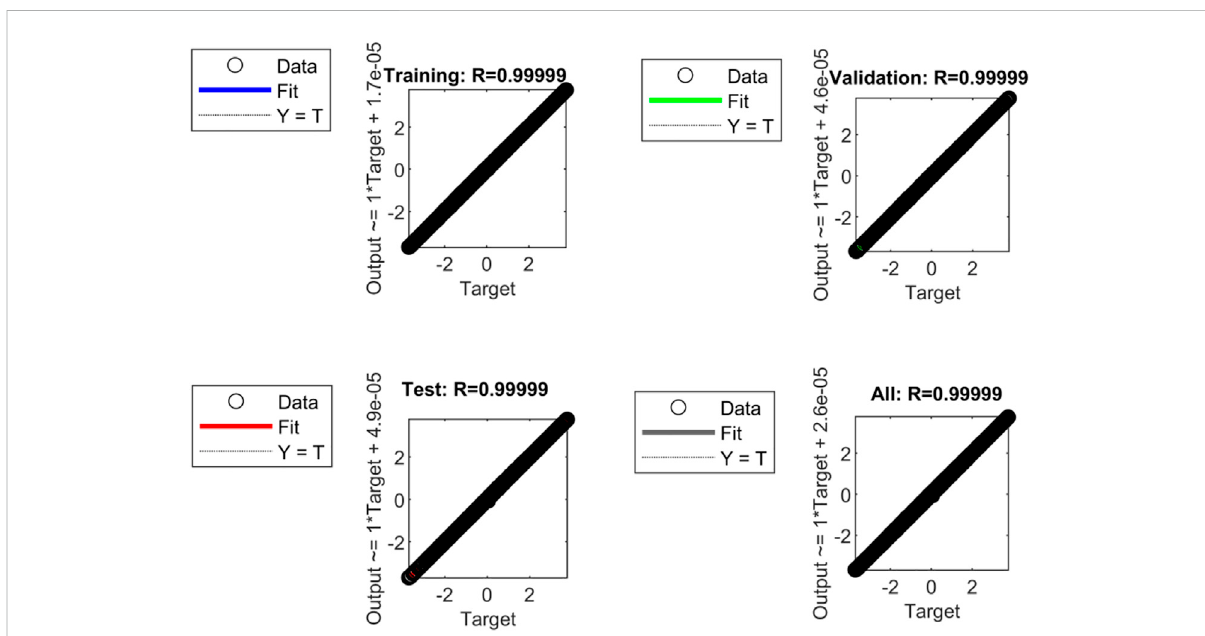
FIGURE 12 Linear regression relations between the predicted values and the target values for the TSANN established for pressure of the primary-circuit